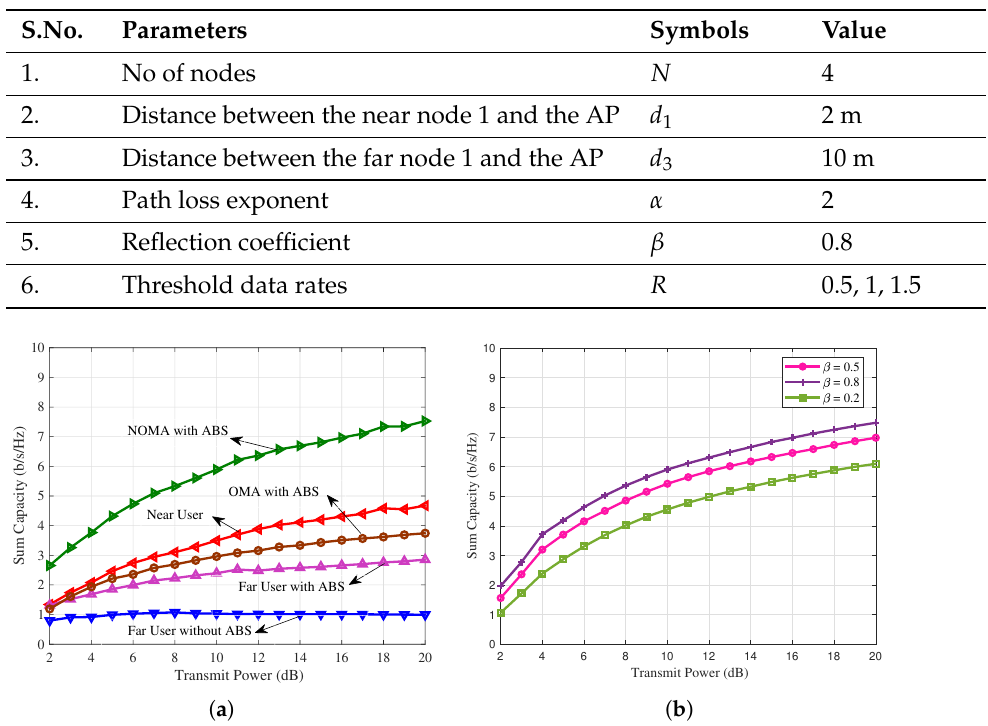
Figure 3. ( a ) Sum capacity of the downlink NOMA with ABS is compared with downlink OMA. ( b ) Sum capacity of the downlink NOMA with various reflection